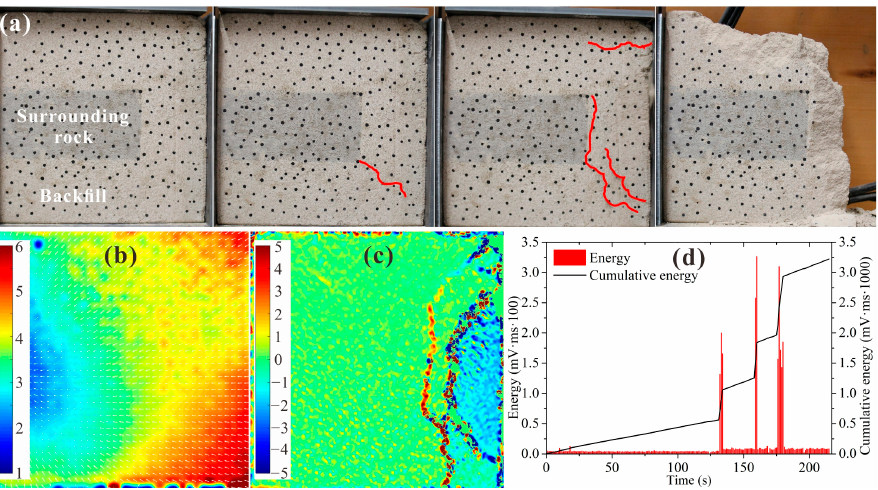
Figure 10. Experimental results for type B. ( a ) Damage and failure processes; ( b ) displacement field; ( c ) strain field; ( d ) acoustic emission energy.